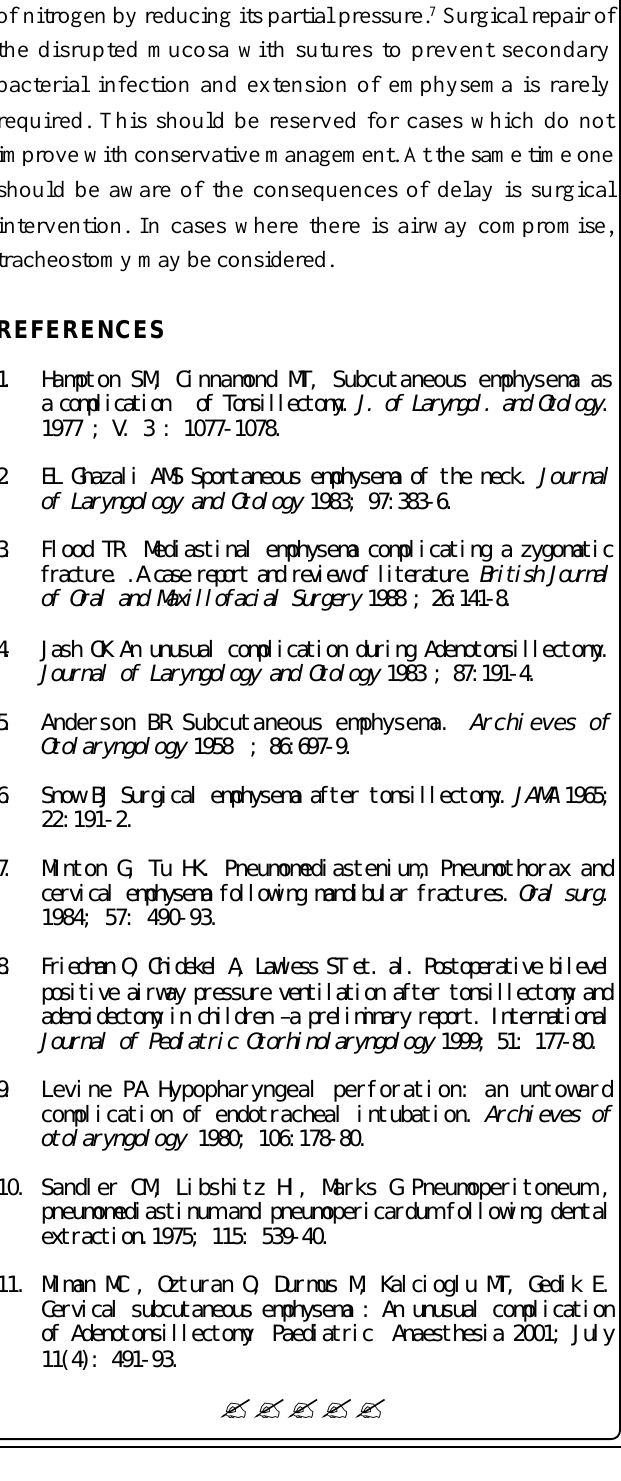
Fig.1 : X-ray Soft tissue Neck showing cervical subcutaneous emphysema on first post operative